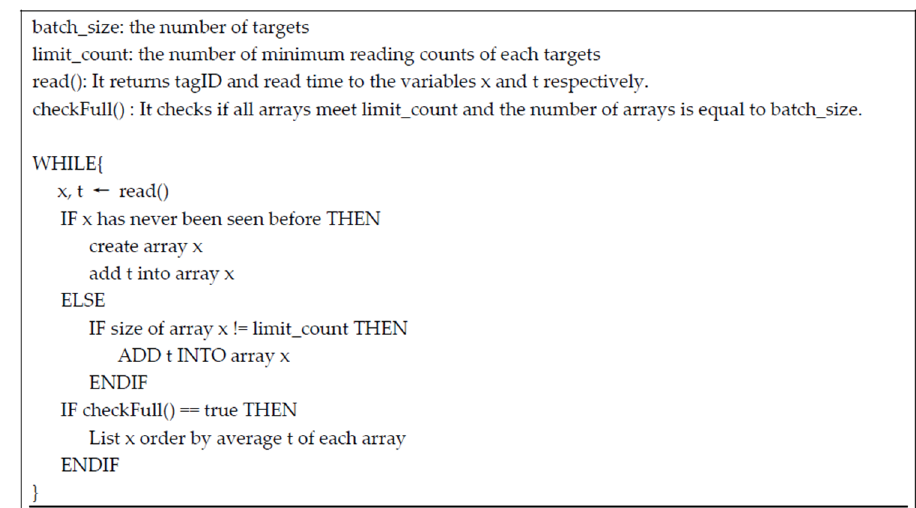
Figure 12. The sequence ‐ checking algorithm.